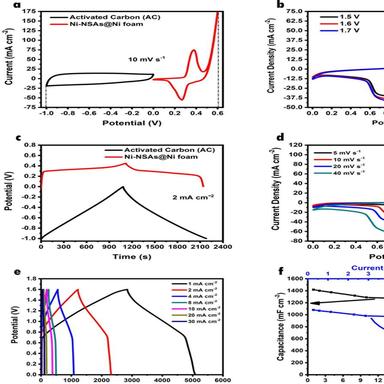
(a) CV curves of Ni-NSAs@Ni foam and AC electrodes at 10 mV s−1 in a three cell electrode mode, (b) CV curves with different voltage ranges at a scan speed rate of 20 mV s−1 , (c) The galvanostatic charge/discharge (GCD) curves of Ni-NSAs@Ni foam and AC electrodes at a current density of 2 mA cm−2 , (d) CV curves of Ni-NSAs@Ni foam//AC device at different scan speed rates, (e) Galvanostatic charge/discharge (GCD) curves of the Ni-NSAs@Ni foam//AC device measured at different current densities and (f) The a